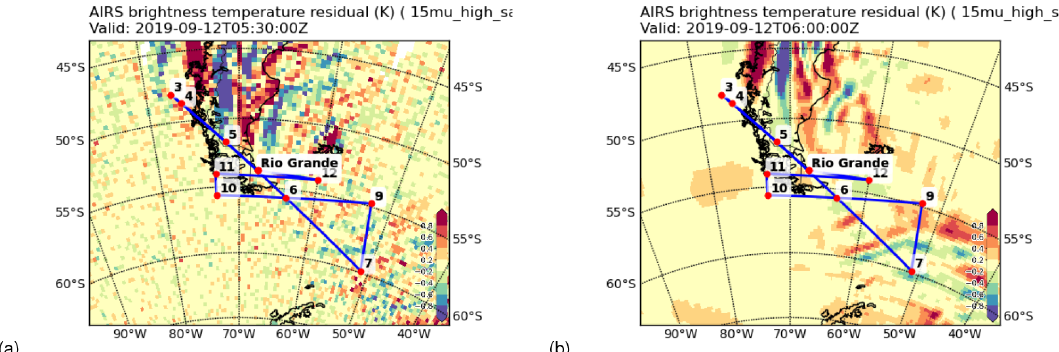
Figure 6. AIRS-related figures: brightness temperature perturbation from AIRS 15µm measurements (a) ; brightness temperature perturba- tions predicted by ECMWF model temperatures (b)